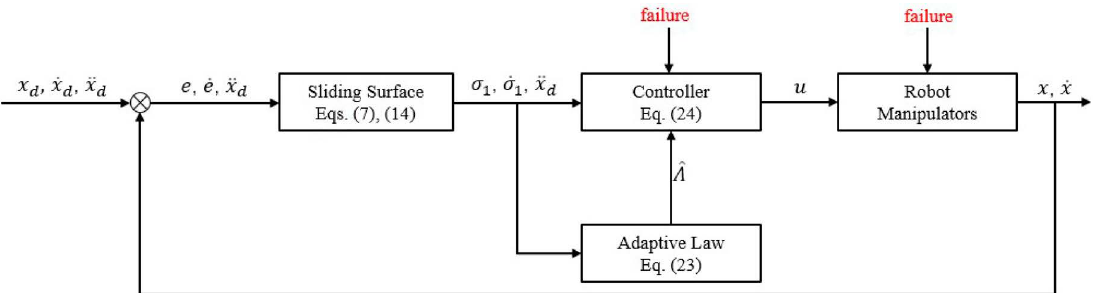
Figure 1. Illustration of the design procedure of